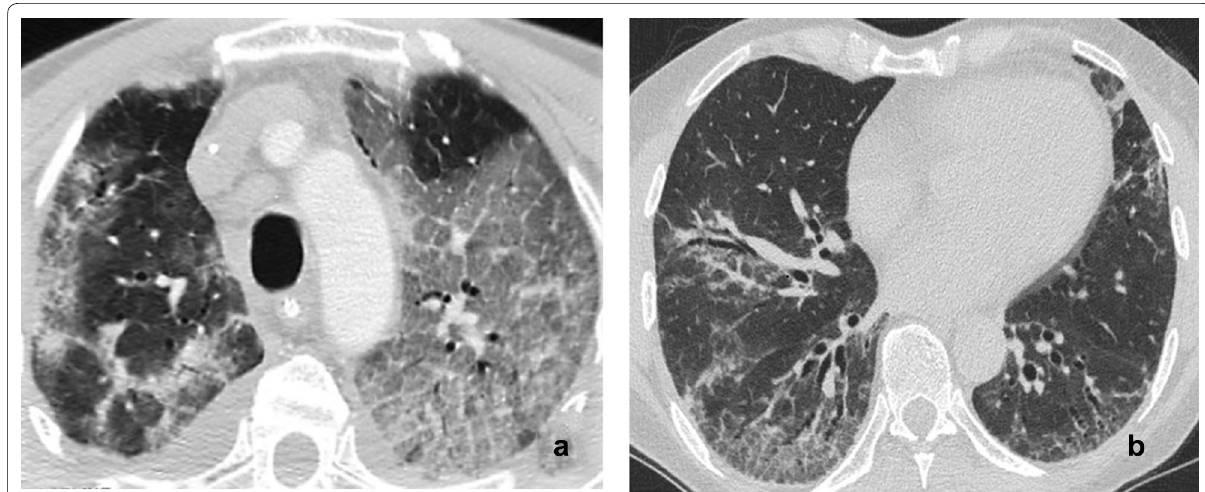
Fig. 2 a Contrast-enhanced computed tomography scan of the thorax of Patient 5 at the level of the carina at ICU admission (slice thickness 2 mm). The picture shows bilateral, diffuse ground-glass opacities with partial subpleural sparing and crazy-paving pattern. b Follow-up high- resolution computed tomography scan of the thorax of Patient 4 at the level of the middle lobe (slice thickness 1 mm). The picture shows bilateral, mainly dorsal ground-glass opacities with reticulations and traction